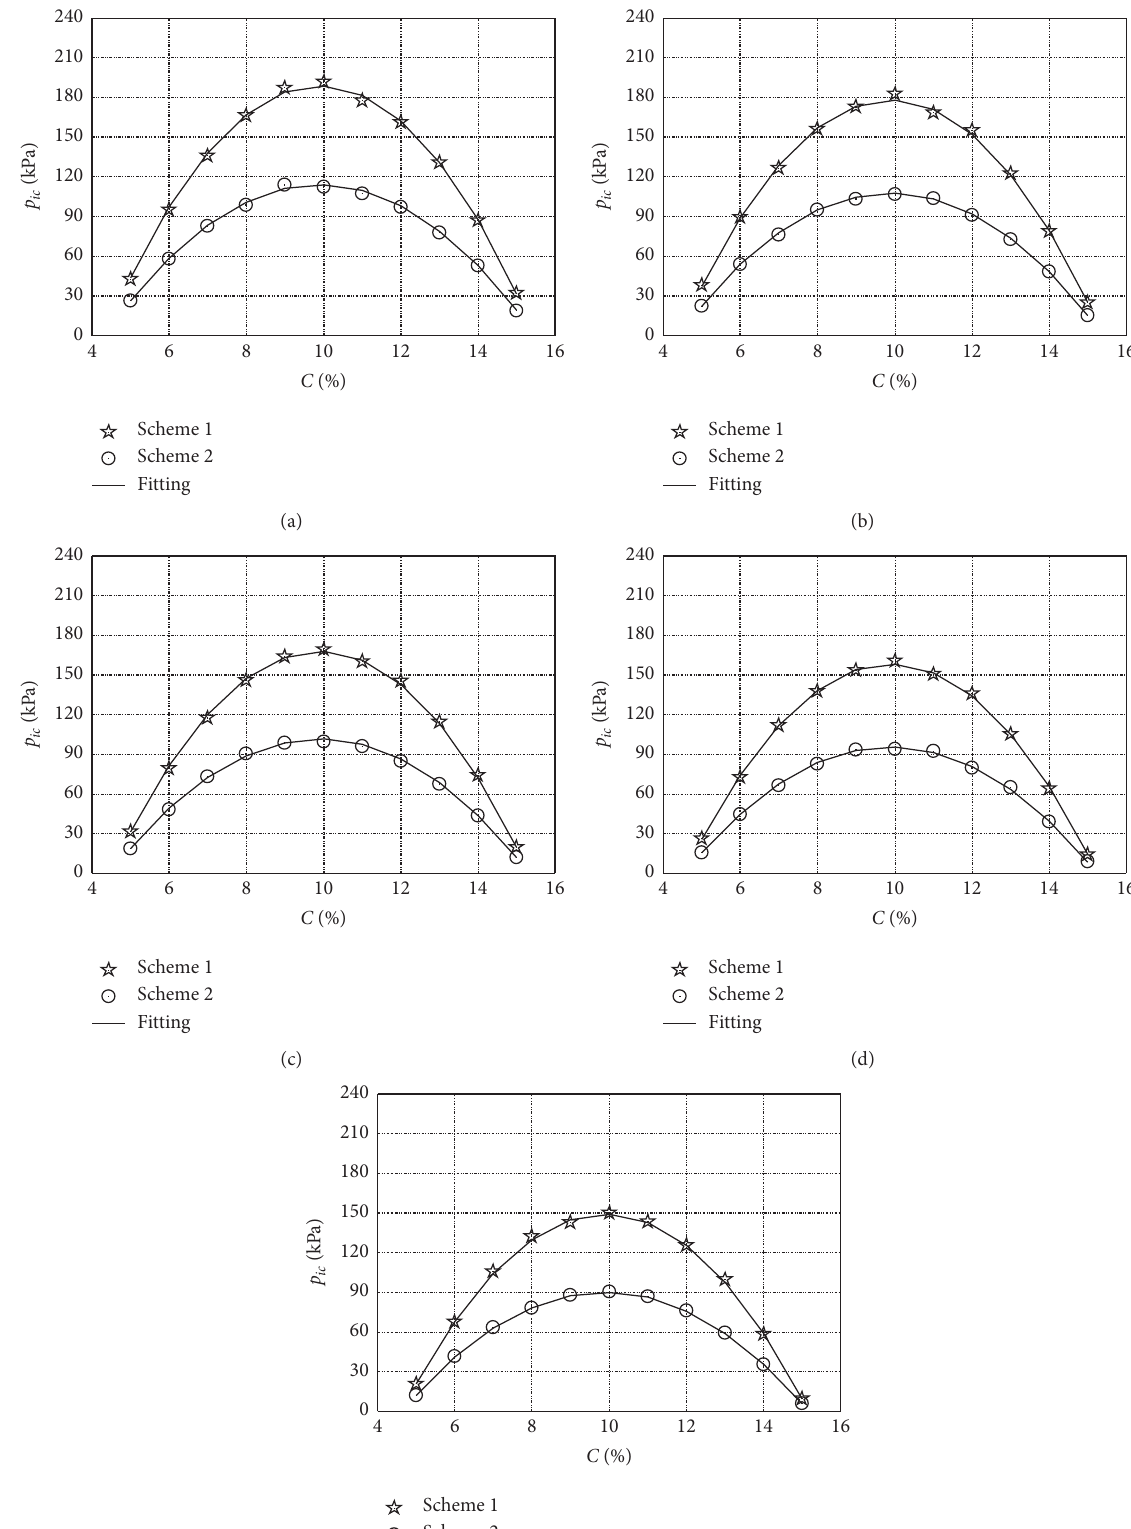
Figure 7: Relation between (p) ic and (C) under different initial temperature environments. (a) (T) (d) (T) � +30 ° C. (e) (T) � +60 °